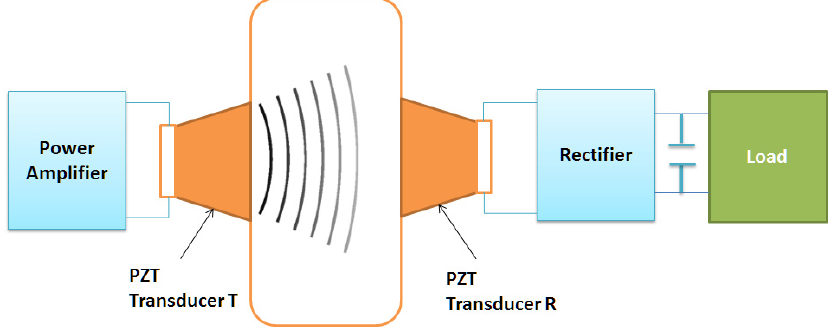
Figure 7. Acoustic power